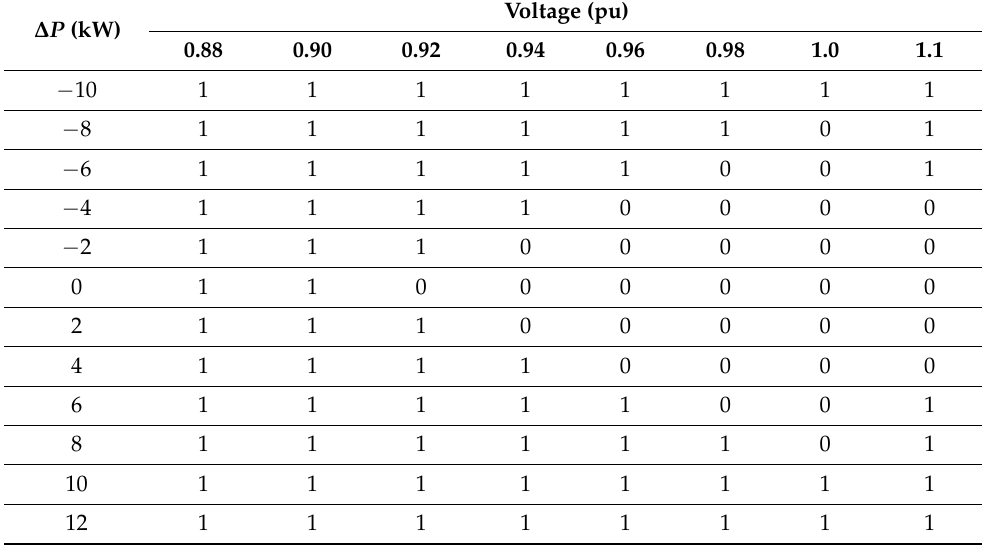
Table 3. Peak magnitude of voltage-based